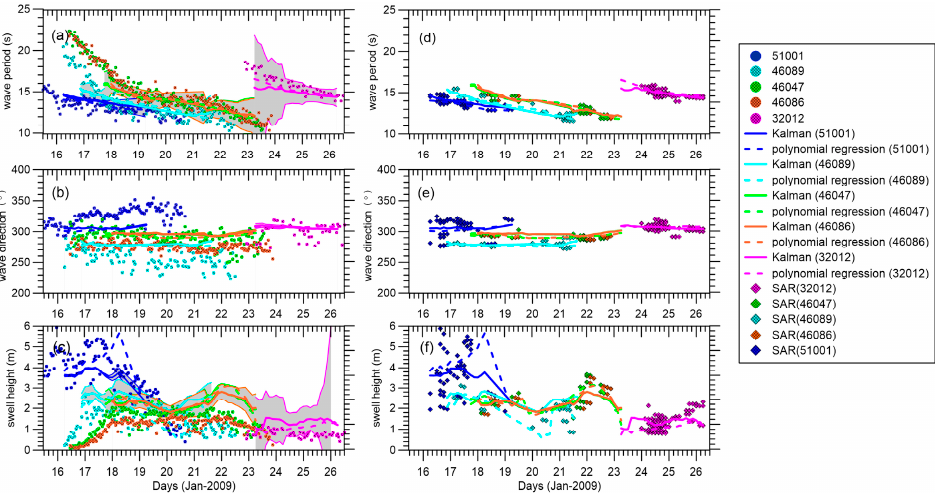
Figure 5. Corresponding swell events tracked at each buoy and plotted with dots with respect to ( a ) wave period; ( b ) wave direction; and ( c ) swell height. The EnKF and polynomial regression swell reconstructions are plotted with solid and dashed lines, respectively. The gray area indicates the 95% confidence interval estimated within the EnKF scheme. The ( d – f ) plots are the same as those of ( a – c ) but are superimposed with pseudo SAR data within 150 km.